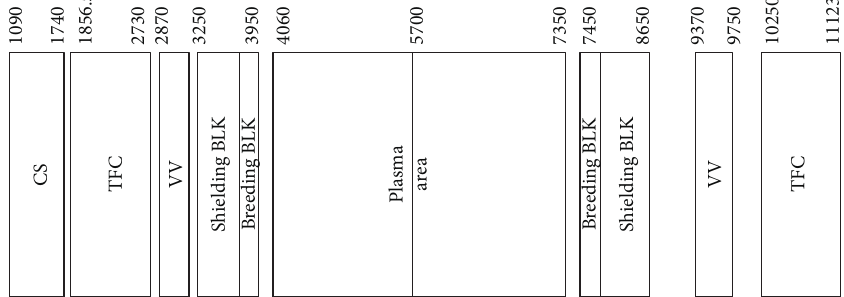
Figure 2: CFETR device radial space